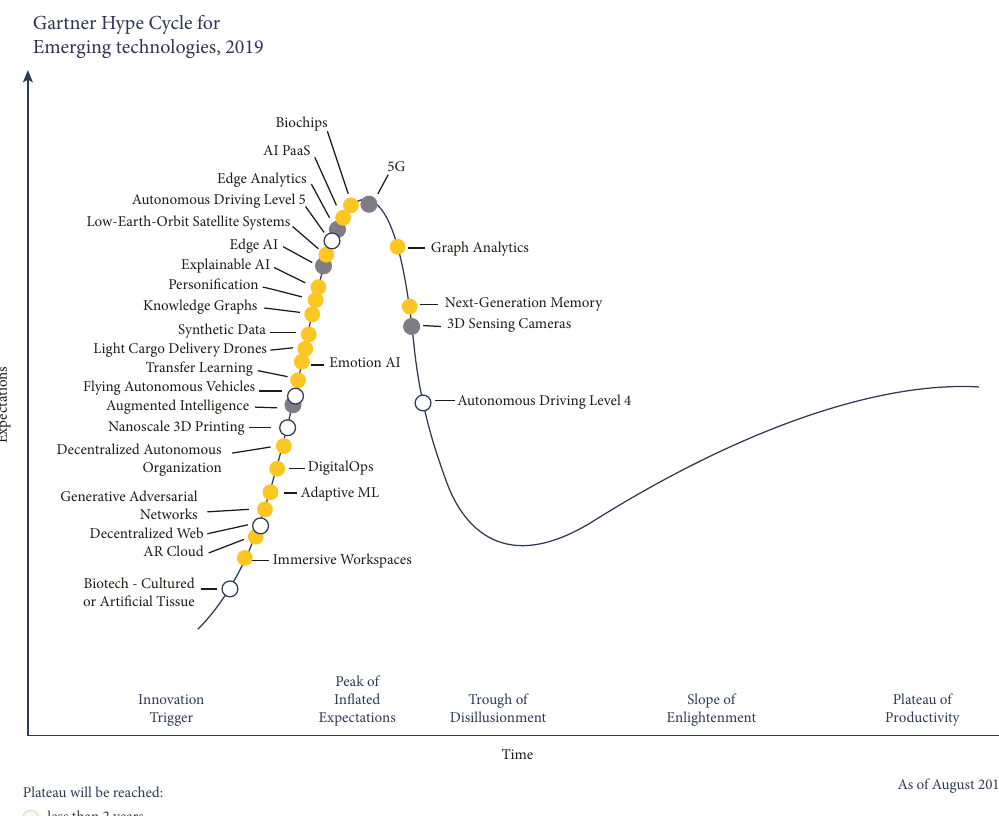
Figure 3: Gartner hype